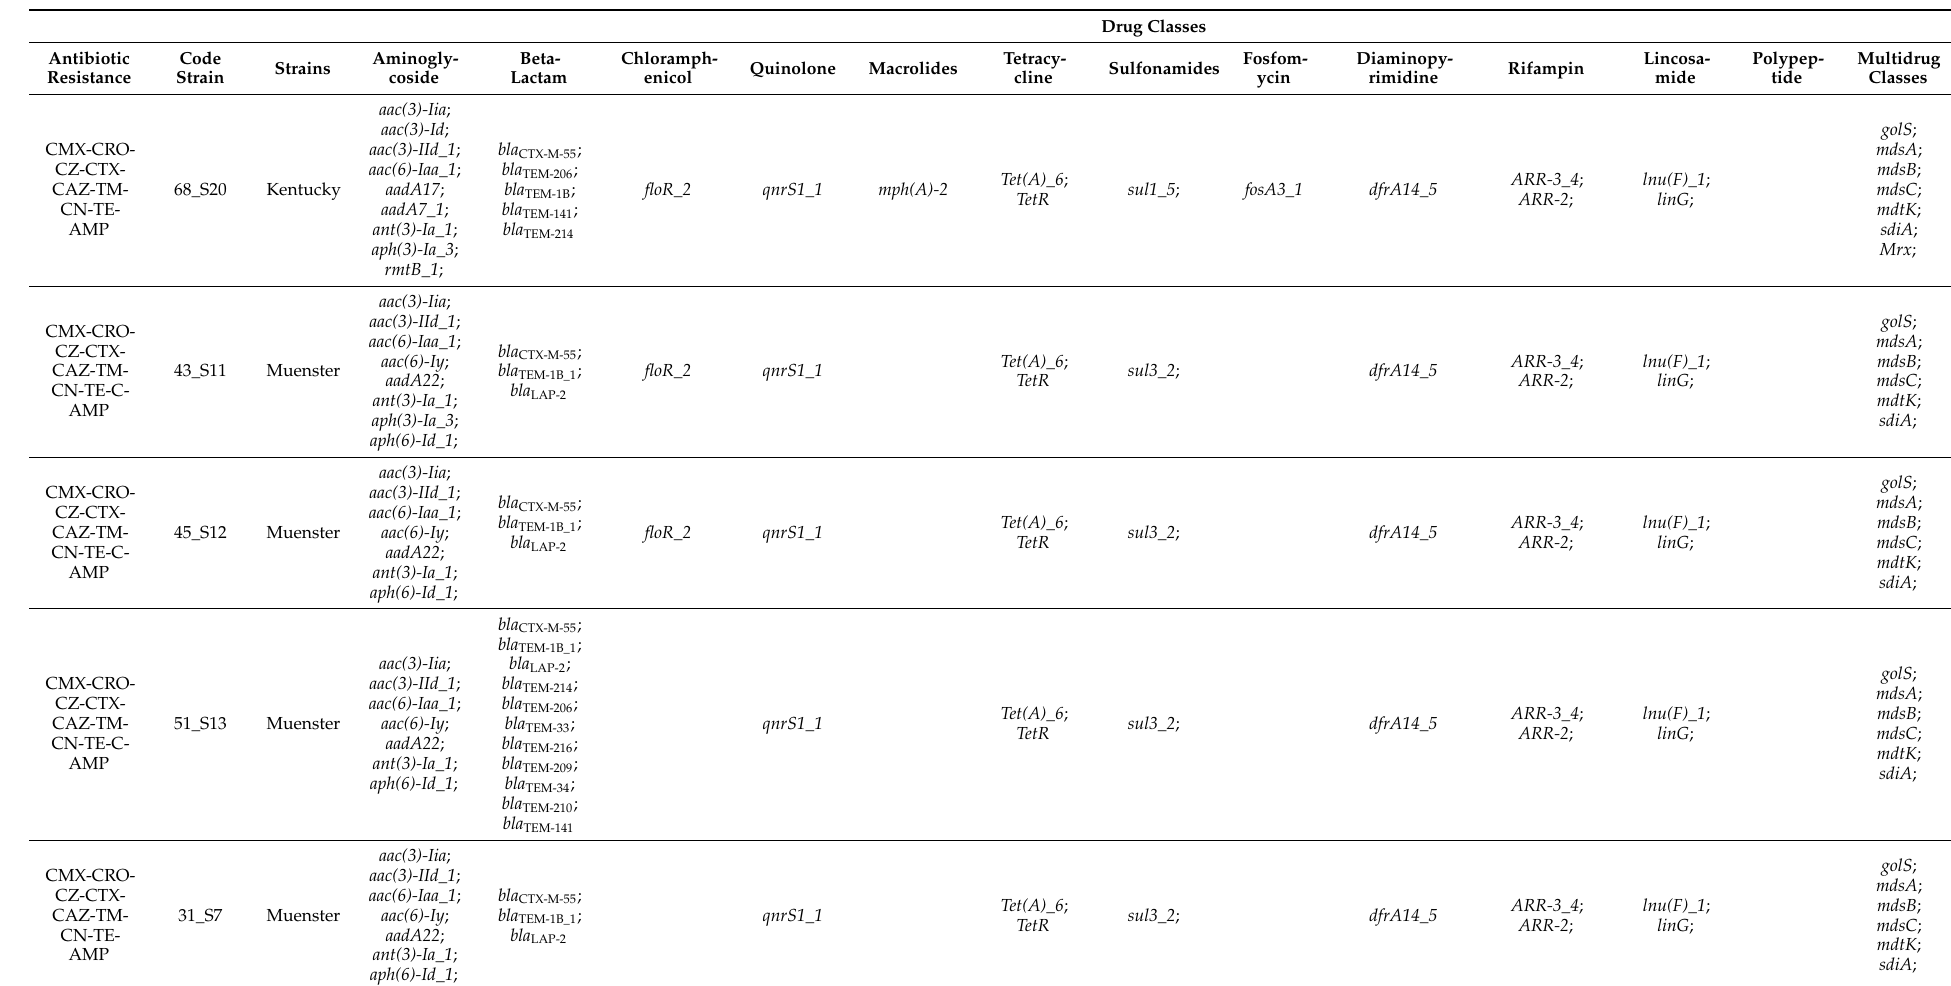
Table A2. Antimicrobial resistance genes in Salmonella